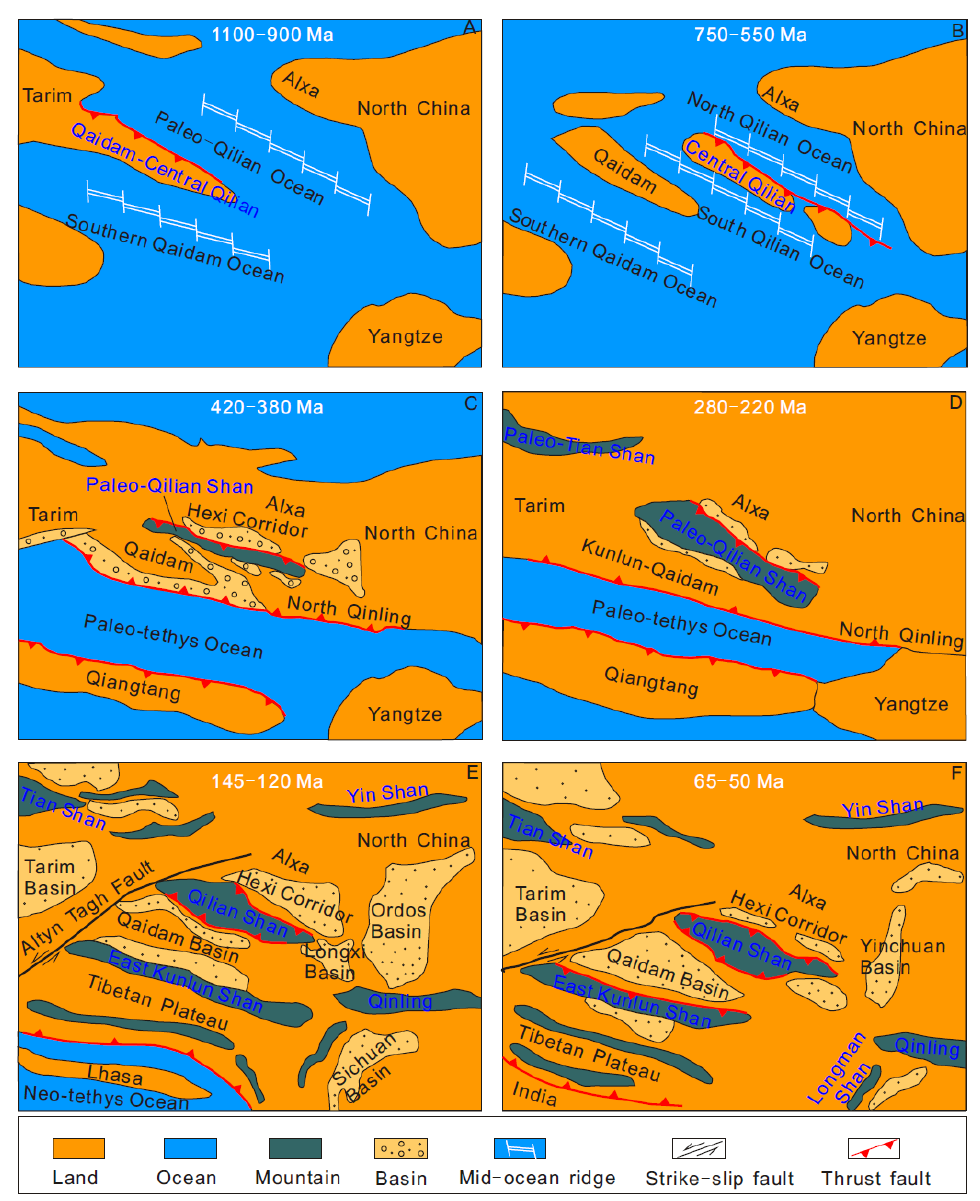
Figure 9. ( A – F ) Tectonic evolution of the Qilian orogenic belts from the onset of the Neoproterozoic to the early Cenozoic (Modified from [7,75,81,116]). The detrital ZFT age population at 800 Ma documents the magmatic-thermal rifting activity and onset of opening of the Qilian Ocean in the North Qilian Shan. This rifting phase was associated to granite intrusions as reflected by the U-Pb ages of bedrock and detrital zircons in the Hei River basin [90], and North [6,7,36], Central [107] and South Qilian basements [117]. During that same period, simultaneous magmatic activities took